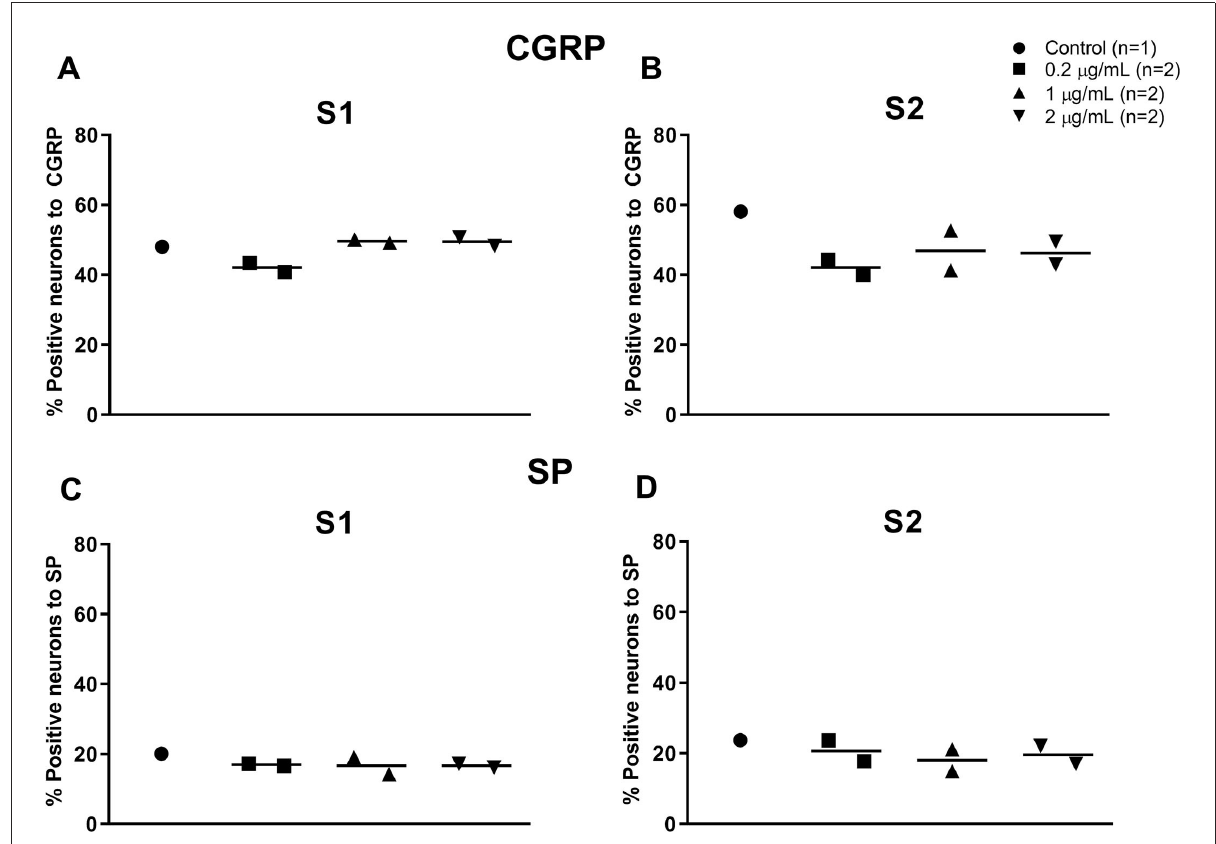
FIGURE4 Individual values and median of cell bodies expressing CGRP (A, B) and SP (C, D) in S1 (A, C) and S2 (B, D) DRG of 7 healthy adult sexually intact female cats 14 days after instillation in the urinary bladder of saline (control; n = 1) or RTX treatment (14 days post-application) at doses of 0.2 ( n = 2), 1 ( n = 2), or 2 ( n = 2) µ g/mL diluted with sterile saline to a total volume of